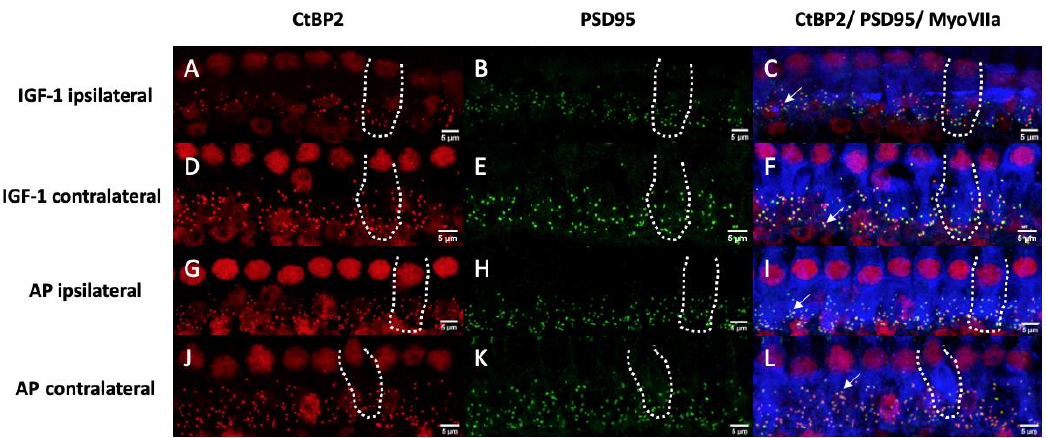
Figure 8. Representative images of the inner hair cells and their synapses corresponding to the 16 kHz region. Hair cells are labeled for myosin VIIa (blue), presynaptic ribbons for CtBP2 (red) and the postsynaptic density is labeled green. Yellow dots indicate an overlapping and therefore a colocalization of the CtBP2 and the PSD95 staining. Doted lines show the contour of a single IHC. Arrows point at synapses with colocalized staining. Left pictures ( A , D , G , J ) show only the CtBP2 staining and pictures in the middle only the PSD95 staining ( B , E , H , K ). The right pictures ( C , F , I , L ) display an overlay of all stainings. ( A – C ) belong to an implanted ear treated with IGF-1. ( D – F ) show a contralateral ear of an IGF-1 treated animal. ( G – I ) belong to an implanted ear treated with AP and ( J – L ) belong to a contralateral ear of an AP treated animal. Scale bars indicate 5 µ m. The two IGF-1 groups had the fewest colocalized counts with equal frequency.